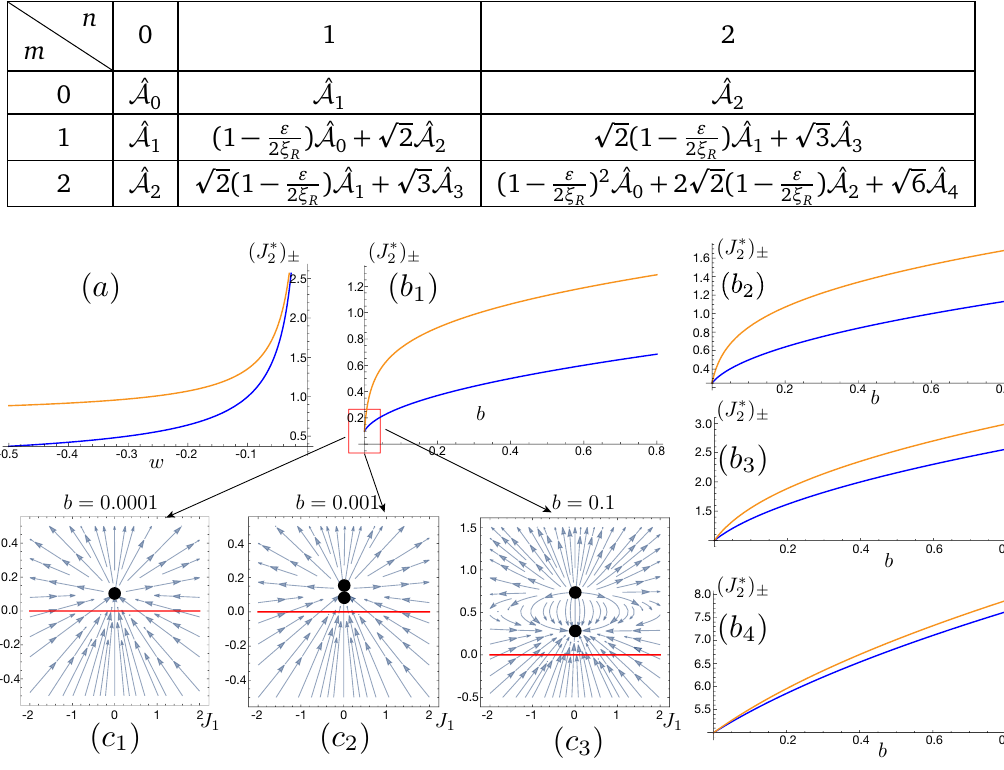
Table 2: Operator product expansion of ˆ